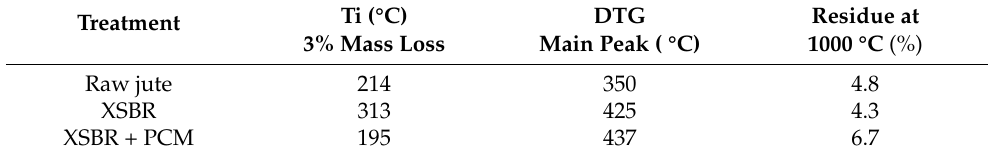
Table 4. Thermal degradation temperature and residue at 1000 °C of untreated and treated jute.